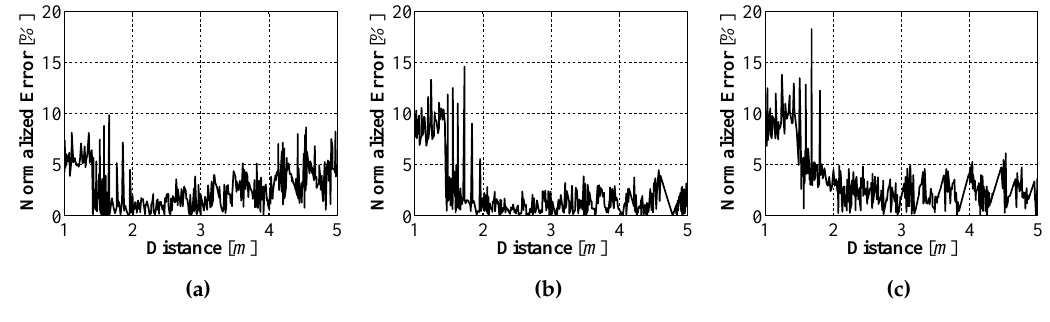
8 ◦ ( a ); 0 ◦ ( b ); and 8 ◦ ( c ). −